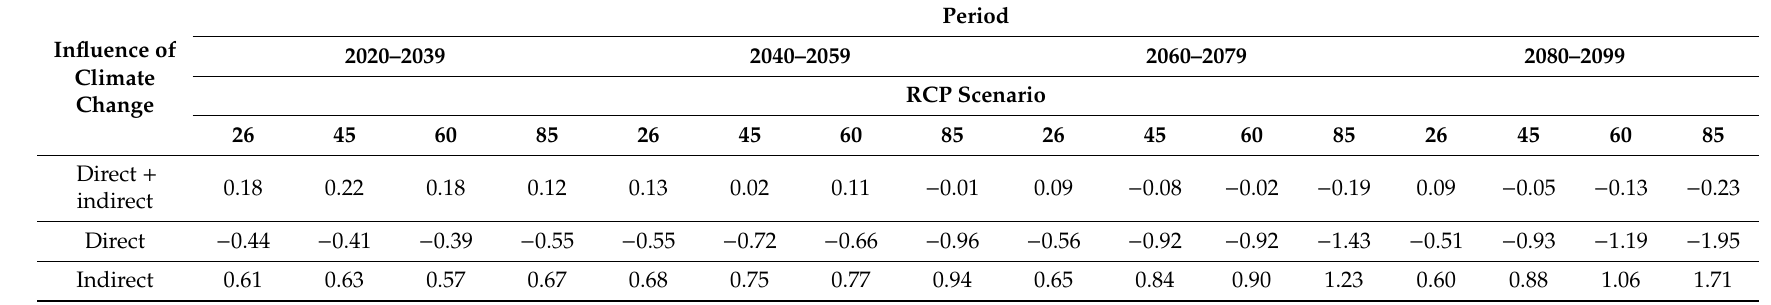
Table 14. Changes of linolenic acid content predicted for four scenarios (RCP2.6, RCP4.5, RCP6.0, RCP8.5) and four periods (2020–2039, 2040–2059, 2060–2079, 2080–2099) influenced by climate